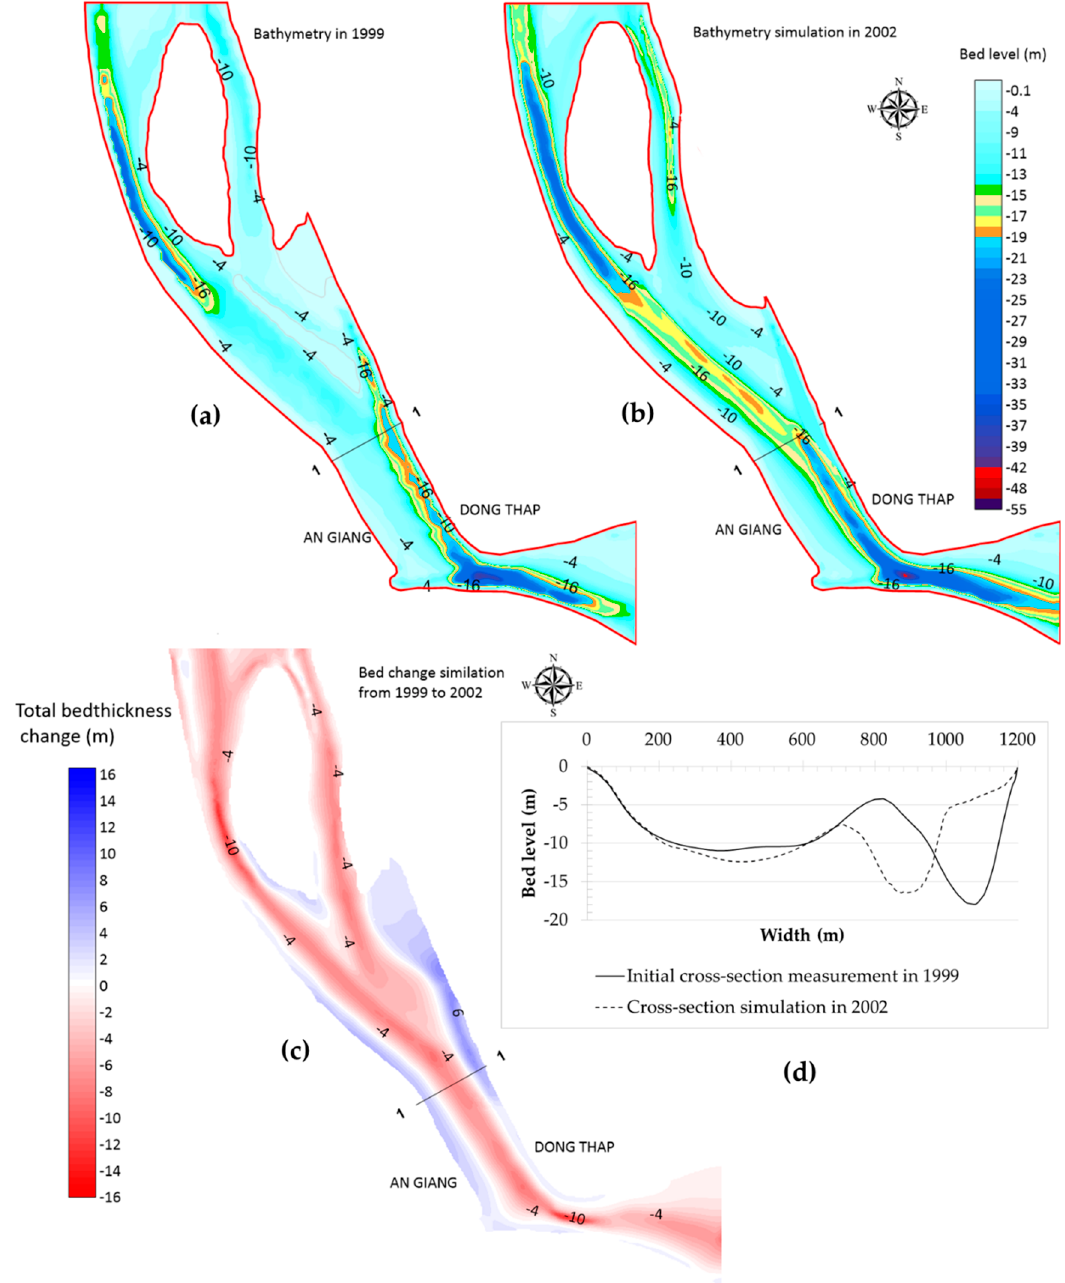
Figure 13. Simulation of the bed changes over 3 years from 1999 to 2002: ( a , b ) figures describing the results of simulations for 1999 and 2002, respectively; ( c ) the bed change simulation during the period; and ( d ) the comparison graphs of simulations at cross-section 1.1.